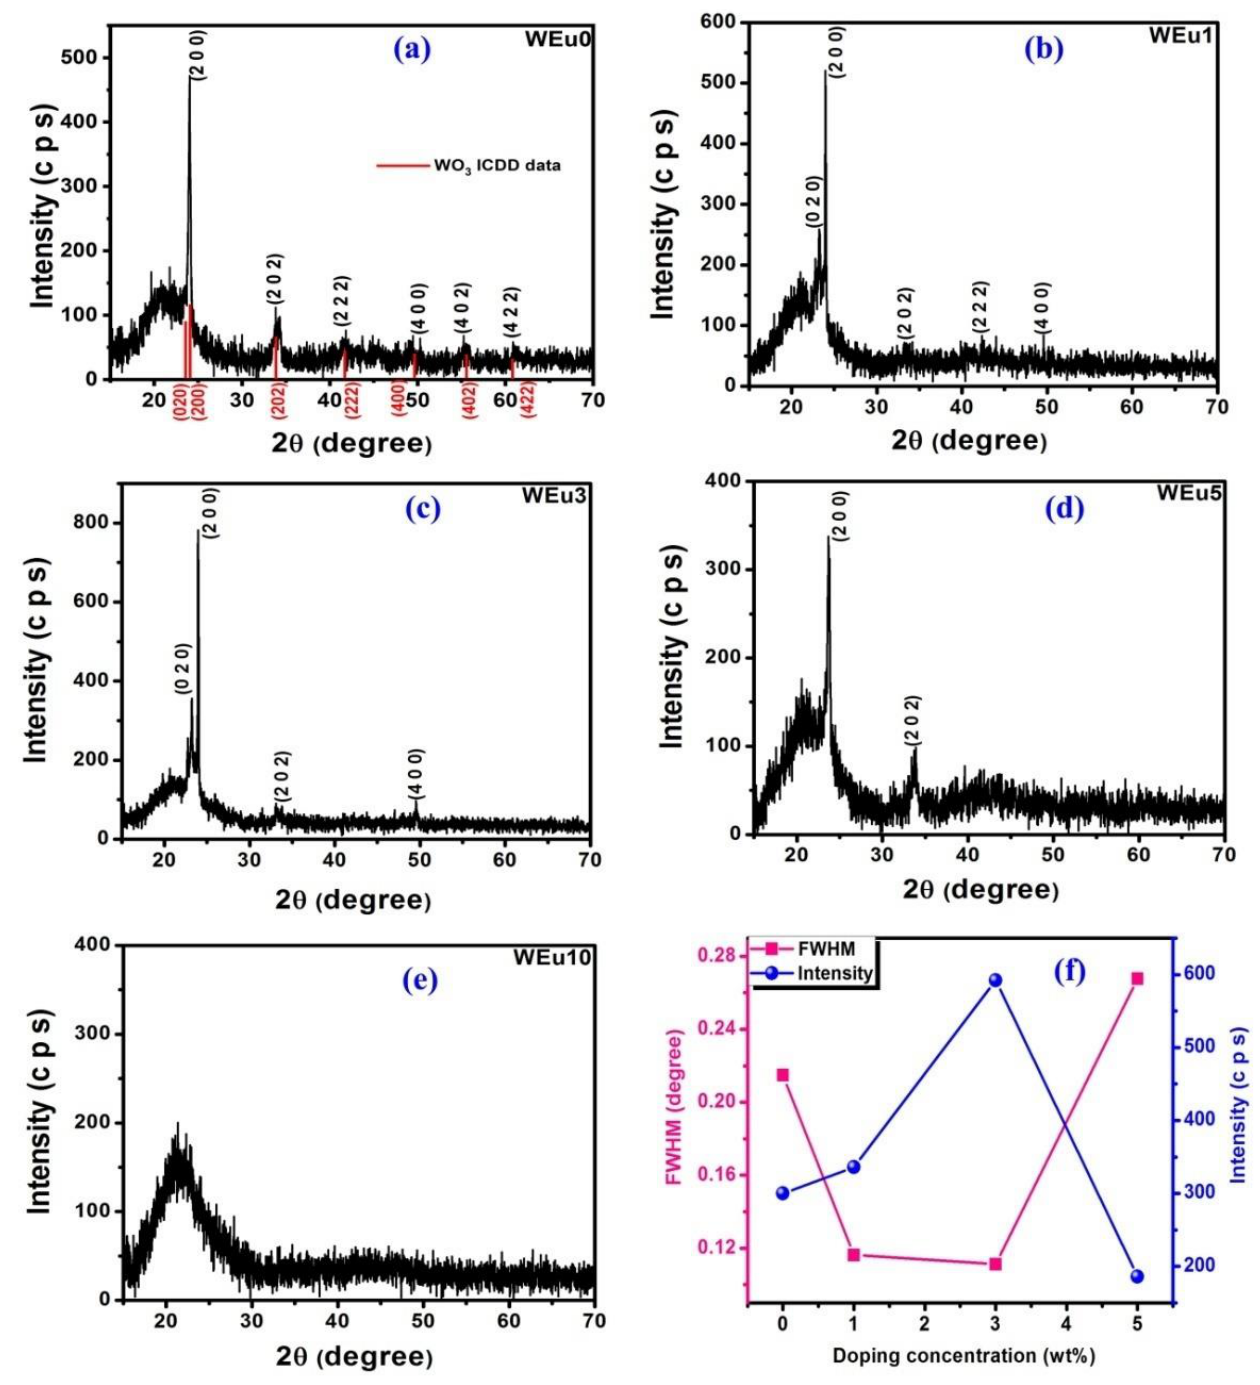
Figure 1. ( a – e ) XRD patterns of the un-doped and Eu 3+ -embedded WO 3 films annealed at 600 °C; ( f ) variation of FWHM and intensity of the (200) peak as a function of Eu 3+ -doping content. The center of the (200) peak shows a systematic shift towards the lower angle side with the enhancement in Eu 3+ -doping concentration, and the observed change in the peak position is shown in Figure 2a. This regular variation in the 2 θ value may be because of the longer ionic radius of the incorporated Eu 3+ (~0.94 Å) [27] compared to the W 6+ host ions (~0.65 Å) [28]. According to Vegard’s law [29], the incorporation of the impurity ions of the longer ionic radii into a lattice of the shorter ionic radii will expand the lattice due to substitutional incorporation, and, hence, the diffraction patterns will move to